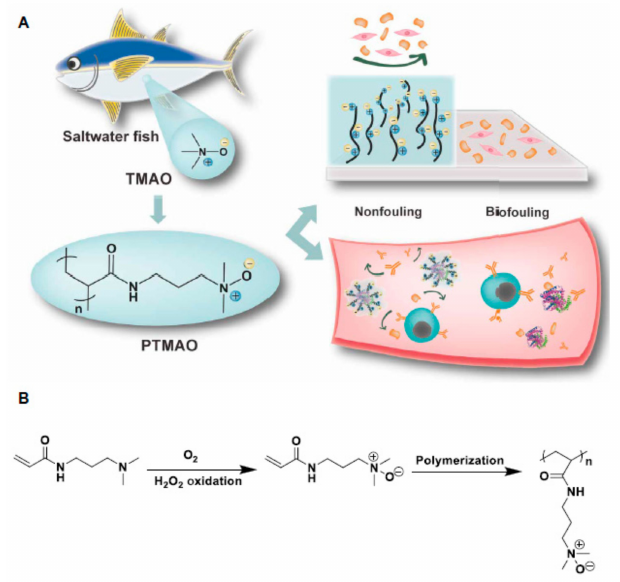
Figure 12. ( A ) Schematic representation of trimethylamine N-oxide (TMAO)-based polymer (PTMAO) anti-biofouling properties when forming hydrogels and ( B ) its synthesis. Reprinted with permission from reference [60]. Copyright (2019) American Association for the Advancement of